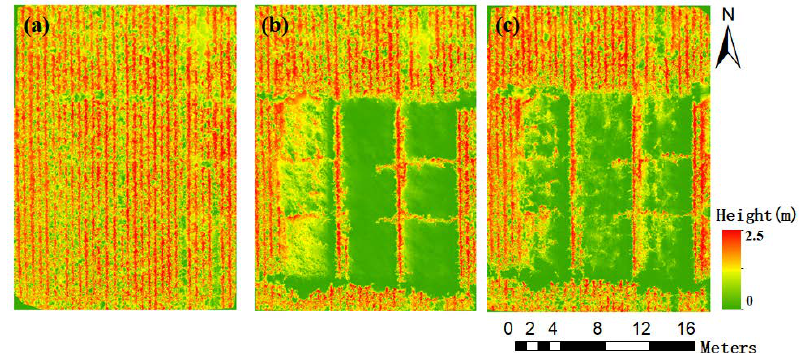
Figure 8. Canopy height changes in the experimental plots. ( a ) No lodging. ( b ) After artificial lodging. ( c ) Lodging for a period of time.